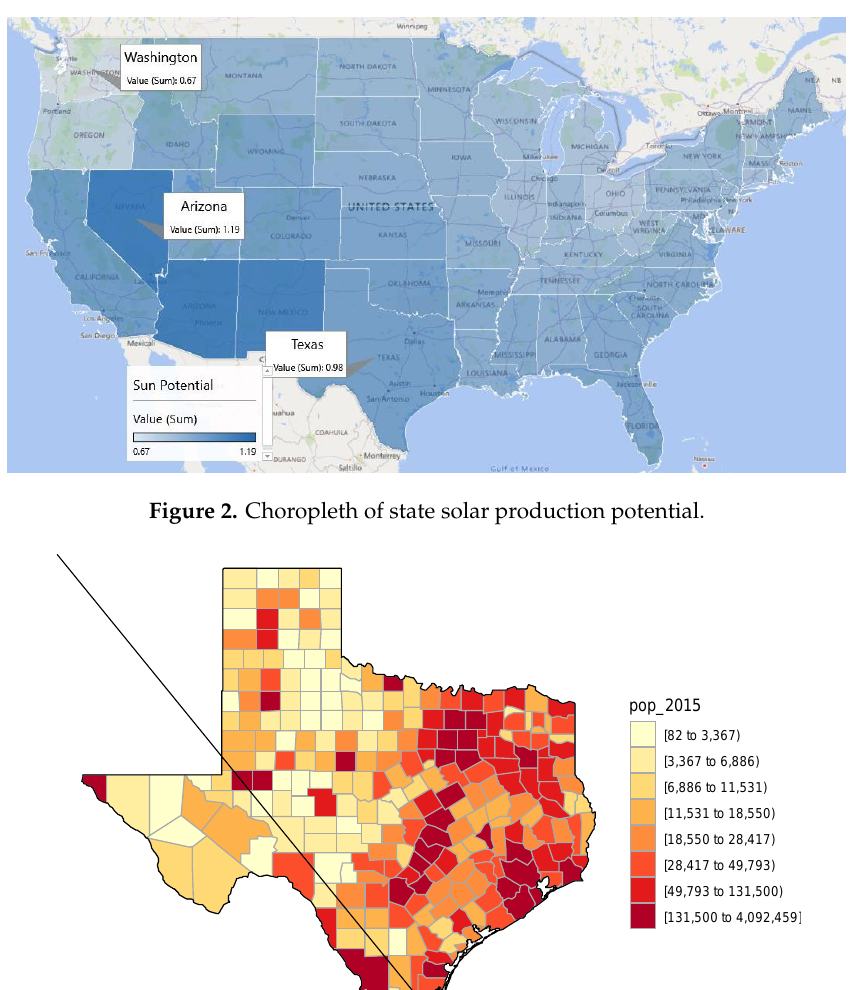
Figure 3. Distribution of Population Intensity in Texas.